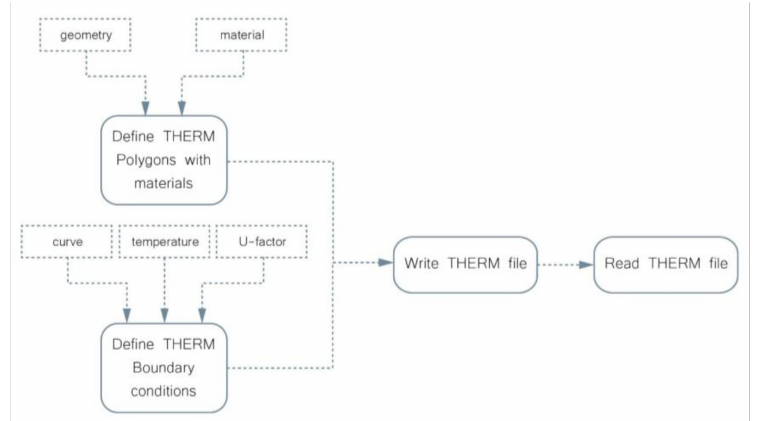
Figure 13. Flowchart of the workflow for the THERM analysis.